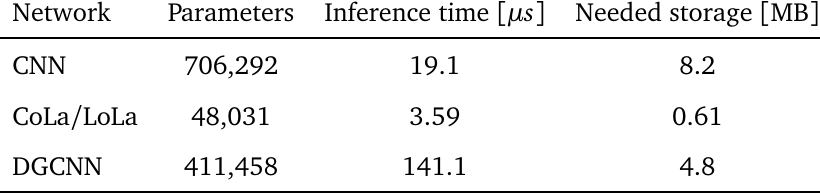
Table 4: Comparison of the number of parameters, the inference time and the storage needed for the different architectures introduced in this